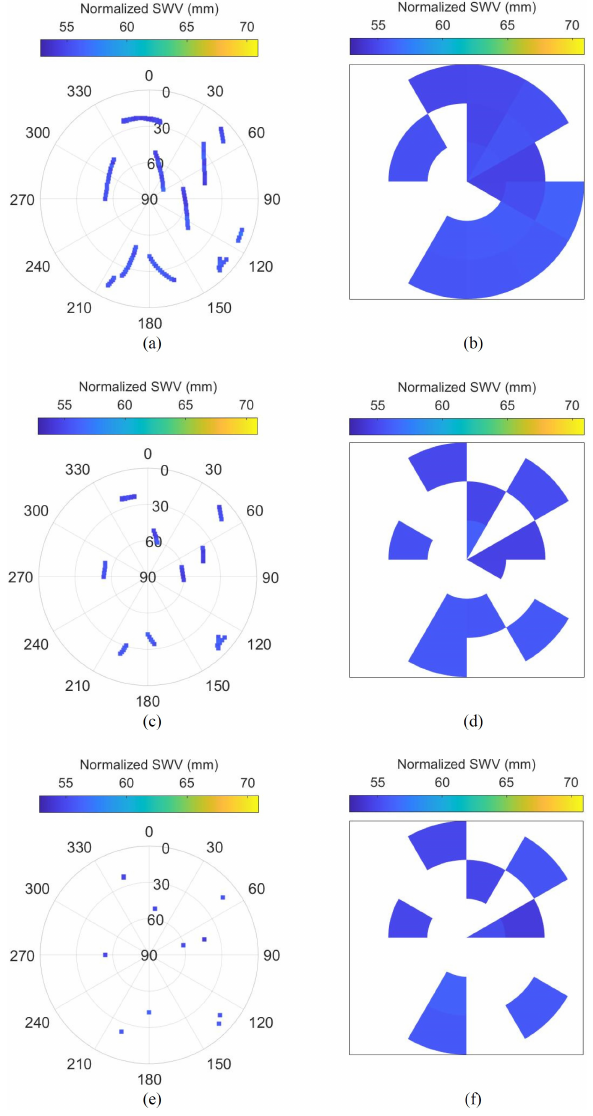
Figure 5. Left: Skyplots of normalized SWV on 21 April 2016, 09:00 local time, over different durations: ( a ) 1 h, ( c ) 20 min, ( e ) 5 min. Right: Spatial plots of normalized SWV over the corresponding durations, ( b ) 1 h, ( d ) 20 min, ( f ) 5 min, based on sectorization with uniform cells of 30 ◦ in both azimuth and elevation